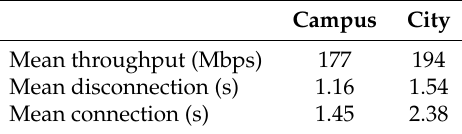
Table 6. Experimental results on driving